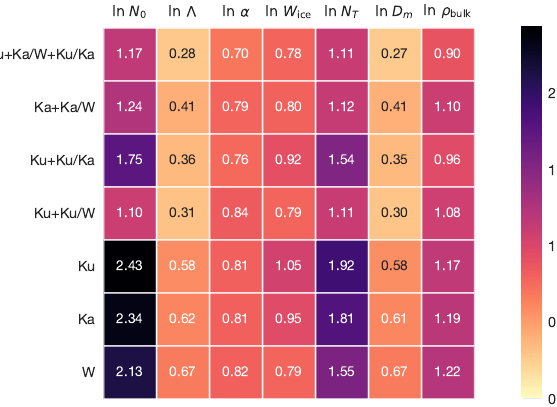
Figure 5. The average posterior retrieval errors of the logarithms of microphysical variables with different combinations of radar fre- quencies. The data from the 4 December 2015 case (Sect. 5.2) are used in this figure.